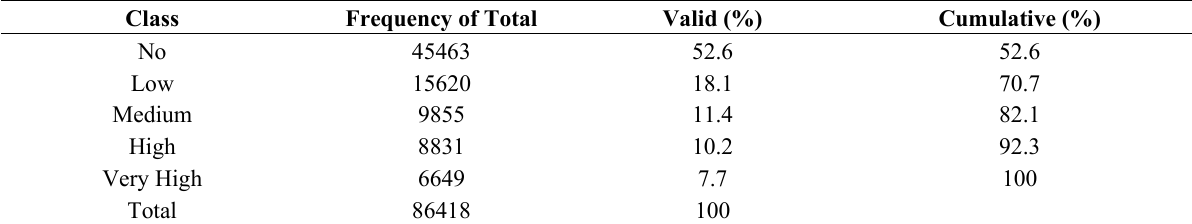
Table 3. Gust classes introduced in this study for use as output/target in C5, Quest and CAHID